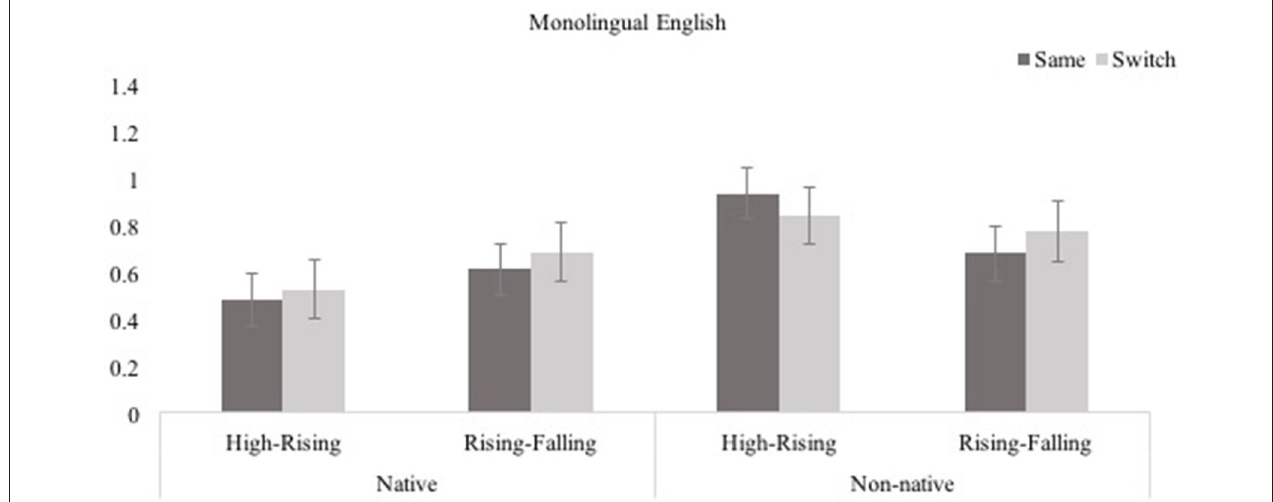
FIGURE 5 | Monolingual English infants’ performance in the four conditions of the switch task (Experiment 3; error bars show SEM).